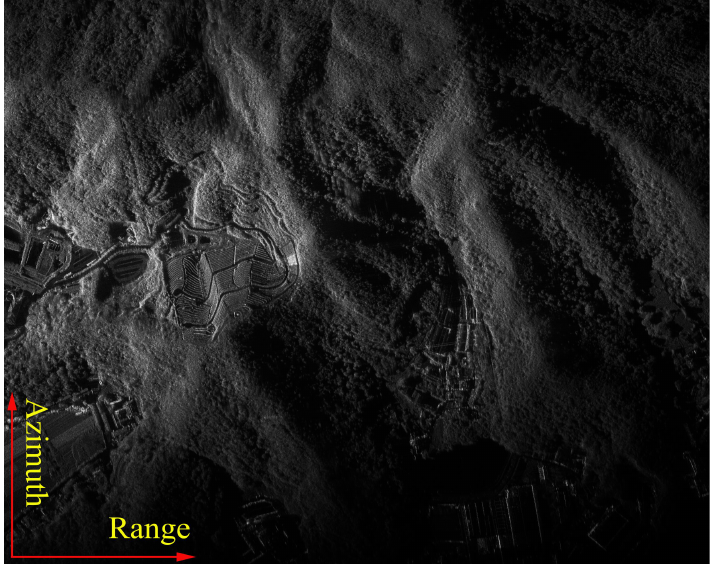
Figure 16. Focused SAR image processed using IETSA, with a squint angle of 10° and a coherent integration angle of 10°.